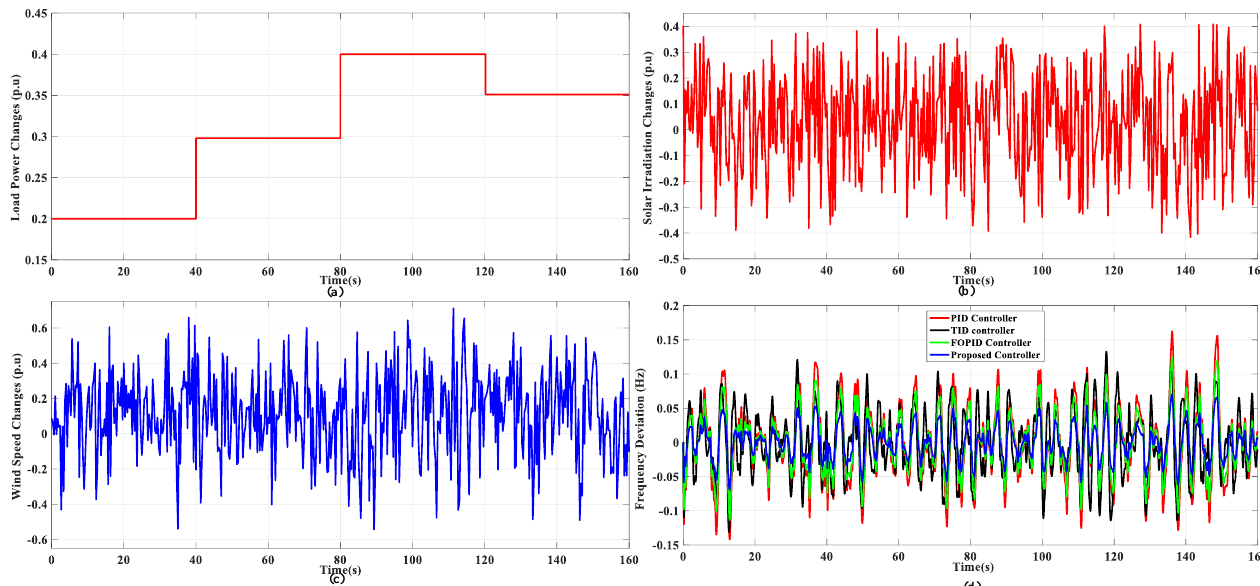
Figure 6. Perturbations and simulation result for scenario 2. ( a ) Load disturbances. ( b ) Wind speed changes. ( c ) Solar irradiation changes. ( d ) Obtained frequency responses.